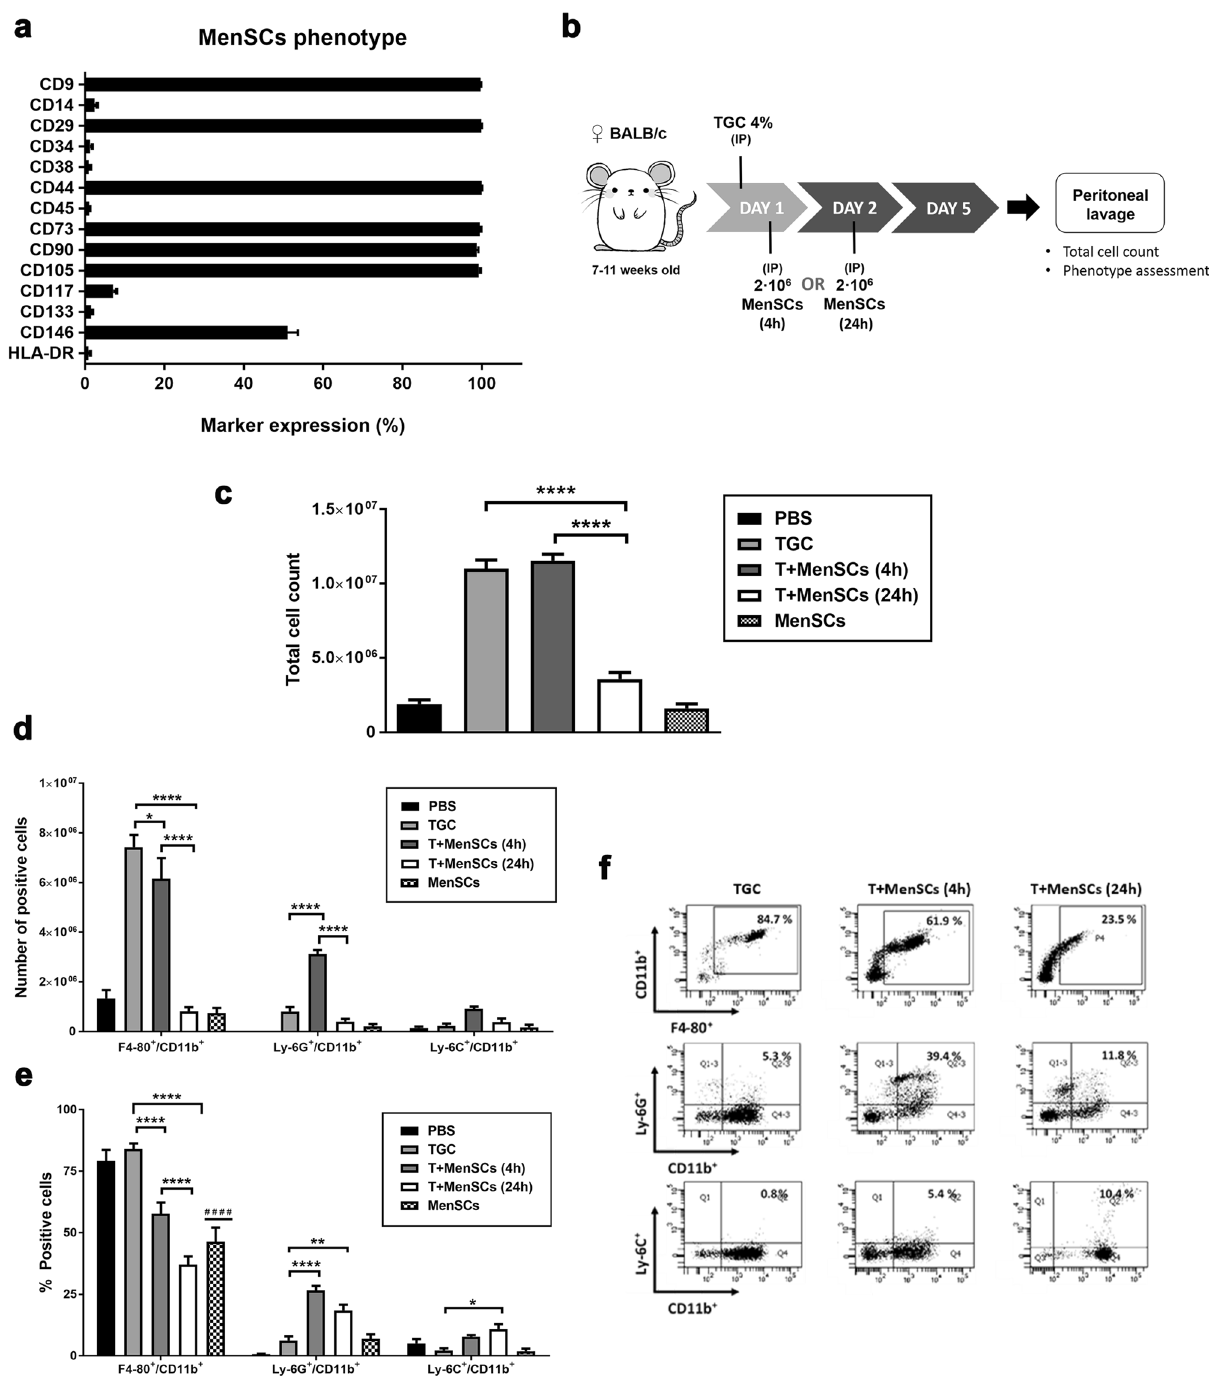
Figure 1. Effects of MenSCs in a TGC-elicited peritonitis mouse model. ( a ) MenSCs phenotype assessment by flow cytometry. ( b ) Overview of mouse model TGC-elicited peritonitis and MenSCs treatment. ( c ) Total number of cells recruited in the peritoneal cavity 4 days after TGC administration. ( d , e ) Phenotypic characterisation of the cells recovered from the peritoneal lavage. Macrophage population was gated as F4-80 + /CD11b + , neutrophils as Ly-6G + /CD11b + and inflammatory monocytes as Ly-6C + /CD11b + . Results are represented as mean ± SEM (n = 4–9 mice per experimental group) . ( f ) Representative flow cytometry analysis of mice peritoneal lavage from TGC, T + MenSCs (4 h) and T + MenSCs (24 h) experimental groups. All experiments were performed using 4 different MenSCs donors. *p < 0.05, **p < 0.01, ***p < 0.001, ****p < 0.0001. Statistical significance compared to PBS group (#). IP intraperitoneal injection, T + MenSCs TGC + MenSCs administration mice